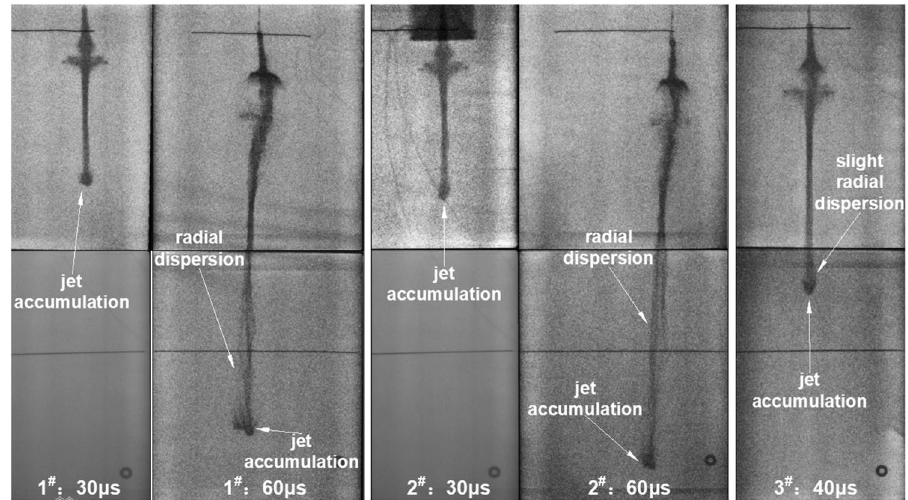
Figure 3. Jet X-ray image.